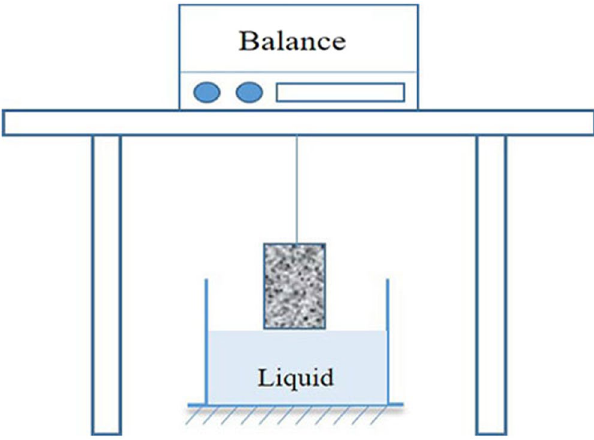
Figure 11. The simple diagram of imbibition experiment.